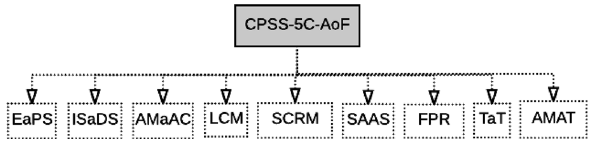
Fig. 1 CPS security in the areas of focus in five levels of